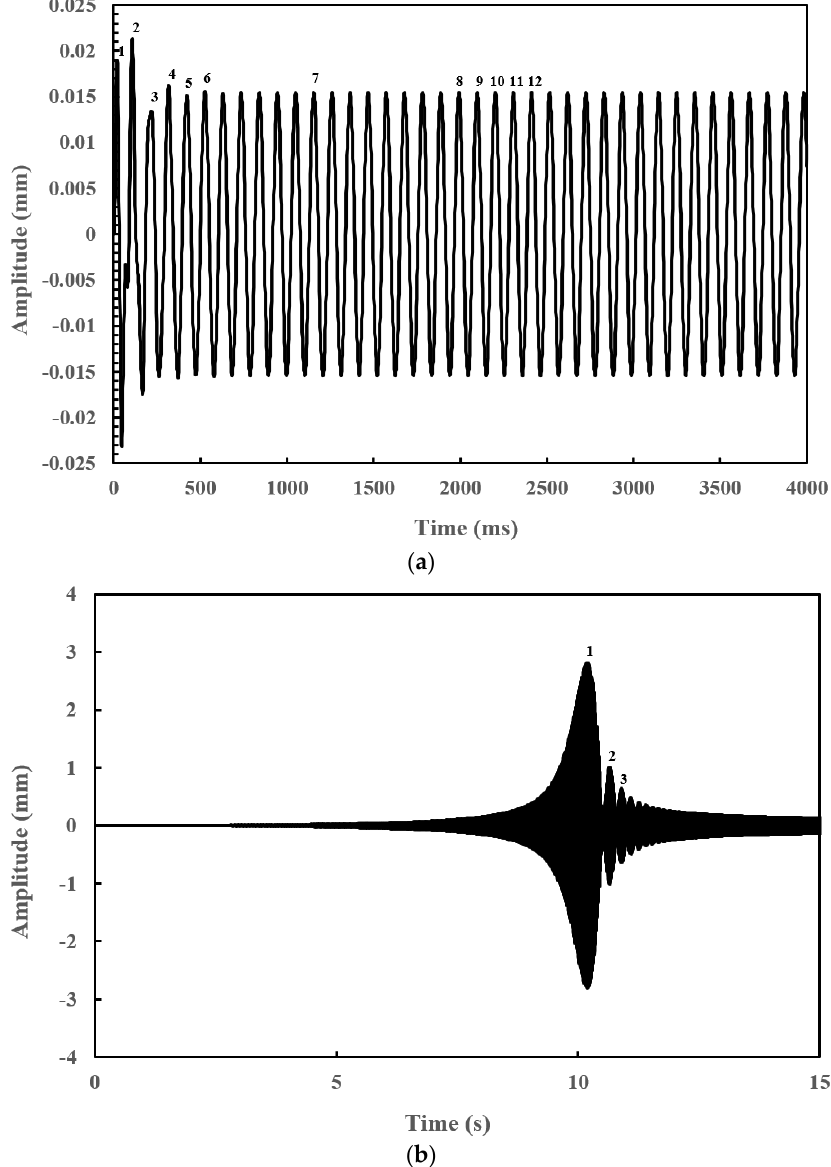
Figure 5. ( a ) Steady − state (rotor speed of 60 rad/s) ( b ) transient time response (angular acceleration of 30 rad/s 2 ) of an uncracked steel rotor − bearing system. Table 3. The amplitude (mm) of the points represented on Figure 5a. Points Present Digitised Values [26] |Difference|